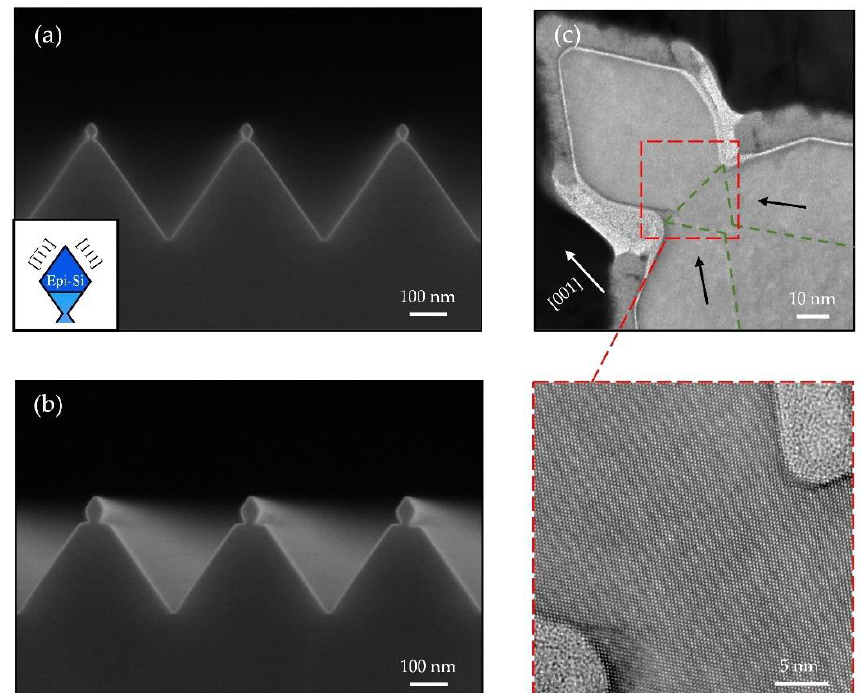
Figure 3. ( a ) Tilted SEM image showing the NW array of epitaxial Si on pre-patterned trapezoidal Si NWs. SEM images of epi- taxial Si NWs obtained after the deposition of 20 nm Si at 380 °C on 30 nm wide pre-patterned trapezoidal NWs ( b ) and on 40 nm wide pre-patterned NWs at 380 °C ( c ). Inset of ( b ) schematically shows the truncated {111}-faceted cross-section.